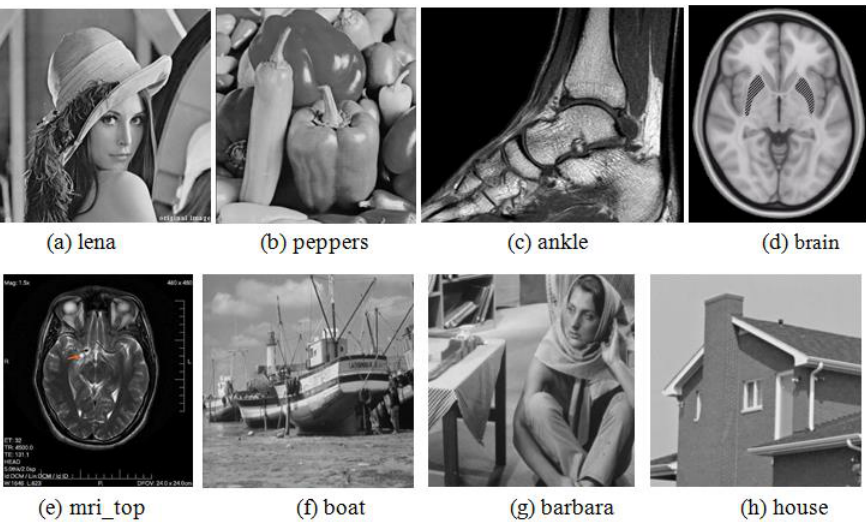
Figure 10. Standard test images: ( a ) lena [51] ( b ) peppers [51] ( c ) ankle [52] ( d ) brain [53] ( e ) Mri_top [54] ( f ) boat [51] ( g ) barbara [50] ( h ) house [51].